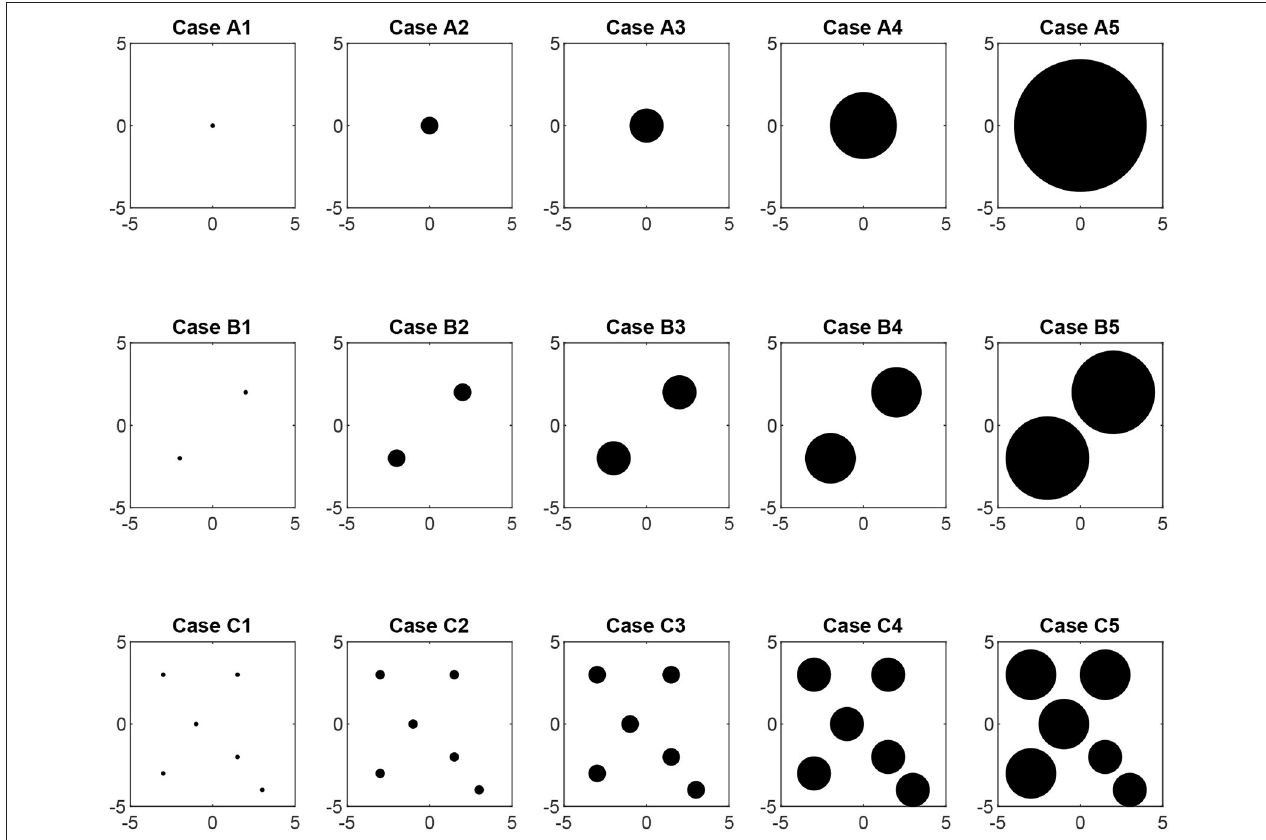
FIGURE 1 | Fifteen cases of obstacle topologies. Particle motion occurs within the white region. Each row corresponds to a different topology, with one obstacle on the first row, two disjoint obstacles on the second row and six disjoint obstacles on the third row. Each column has comparable surface area where particles are allowed to